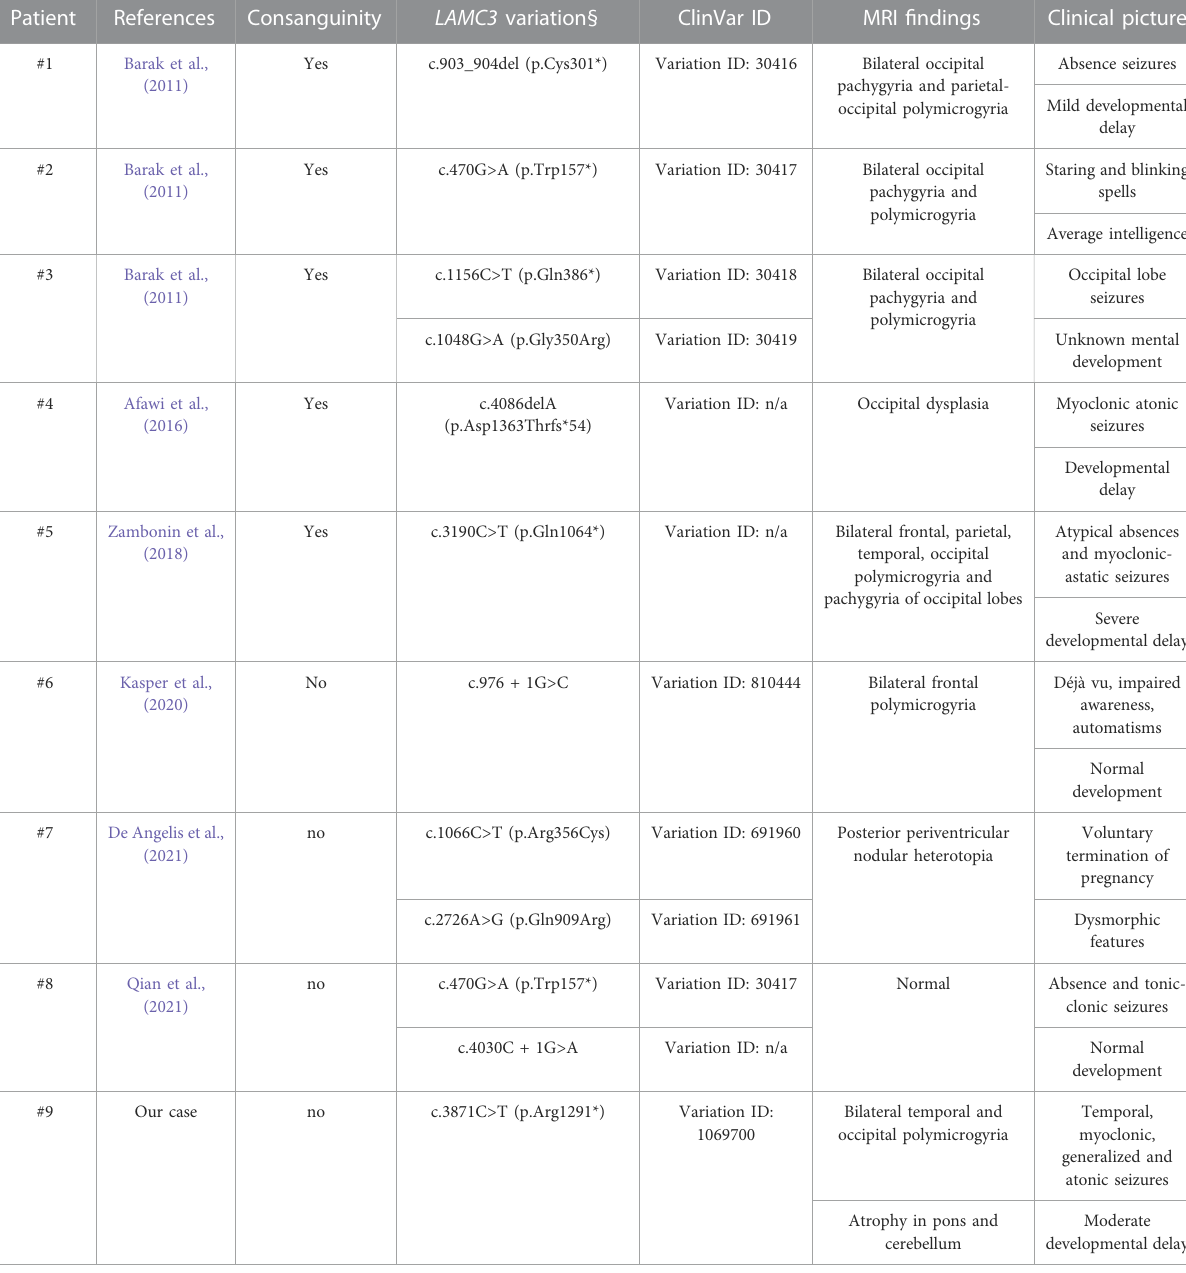
TABLE 1 Summary of previous LAMC3 variations with associated clinical and neuroradiological